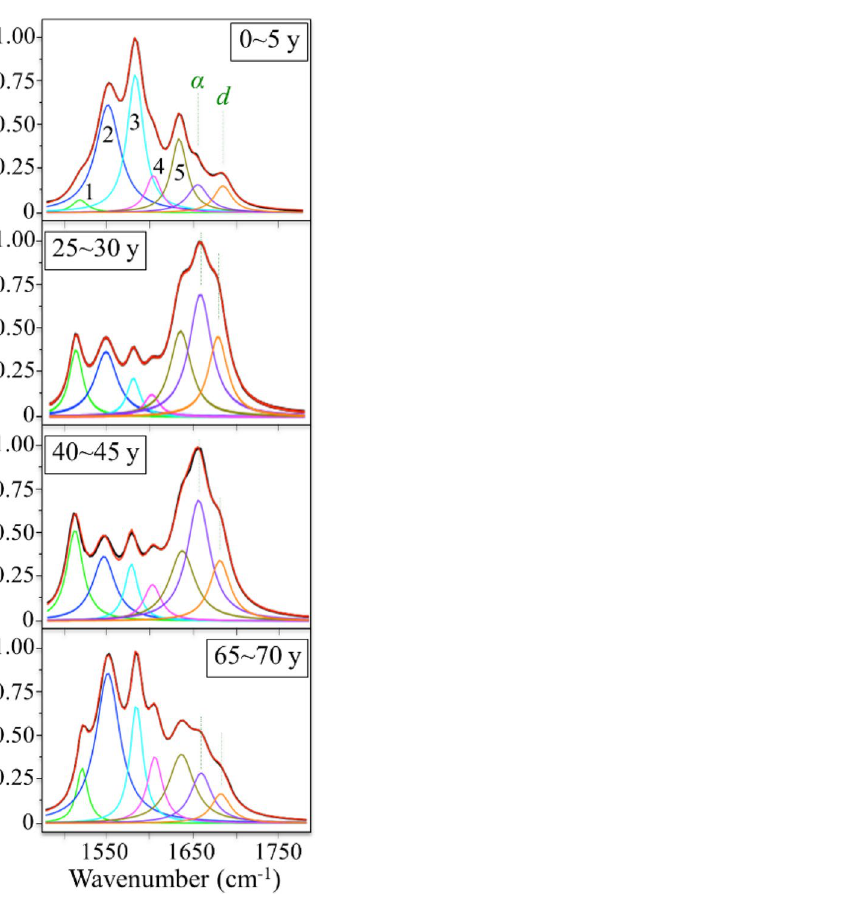
Figure 3. Average Raman spectra from skin samples from the patients listed in Table S1 for the selected age intervals (shown in inset). Spectroscopic related to the proteins are shown. In the protein spectral zone, the labels α and d refer to α-helix and disordered structures, respectively. The vibrational origins of all labeled bands are listed in Table S2 of the Supplementary Materials and are visualized in Fig.